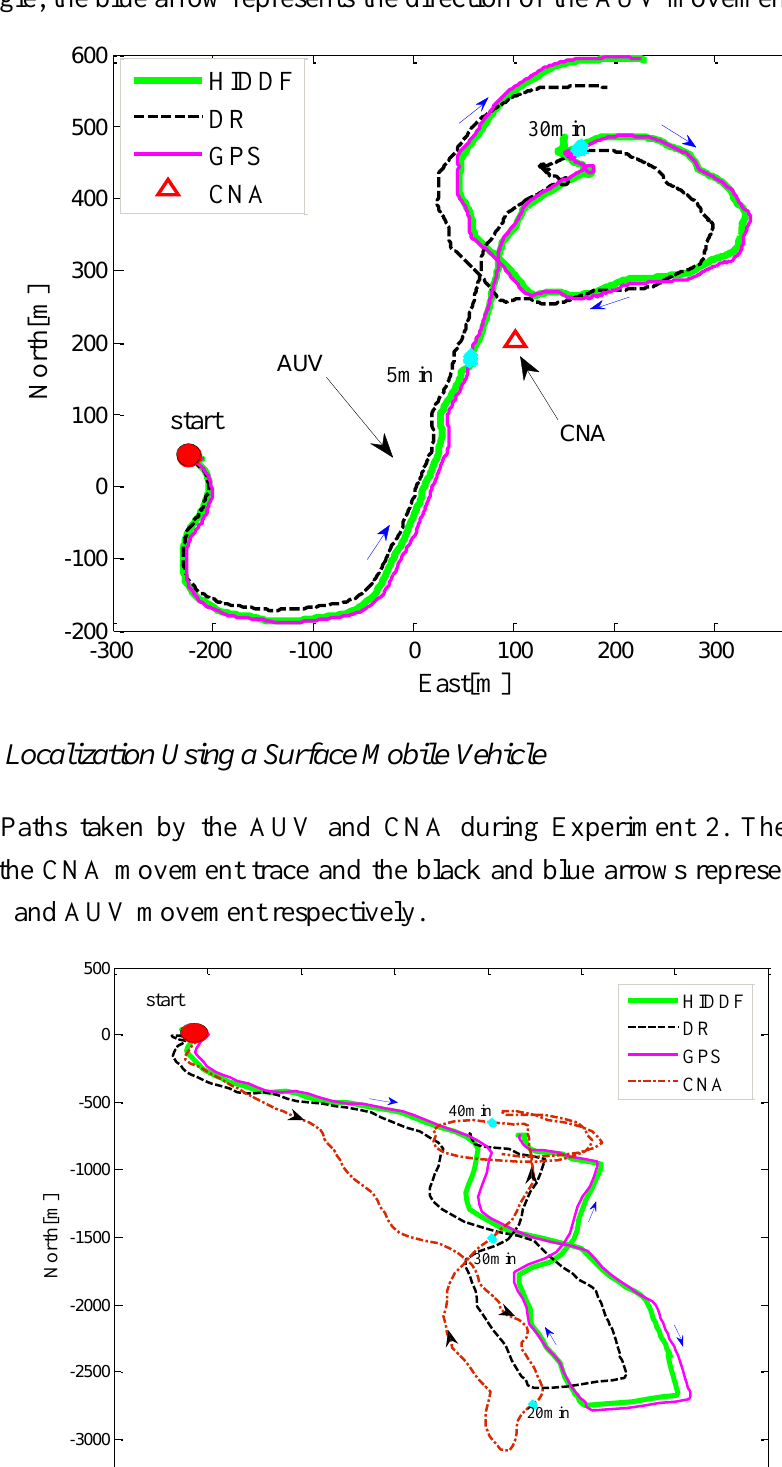
Figure 3. Paths taken by the AUV and CNA during Experiment 1; the static CNA is shown as red triangle, the blue arrow represents the direction of the AUV movement.